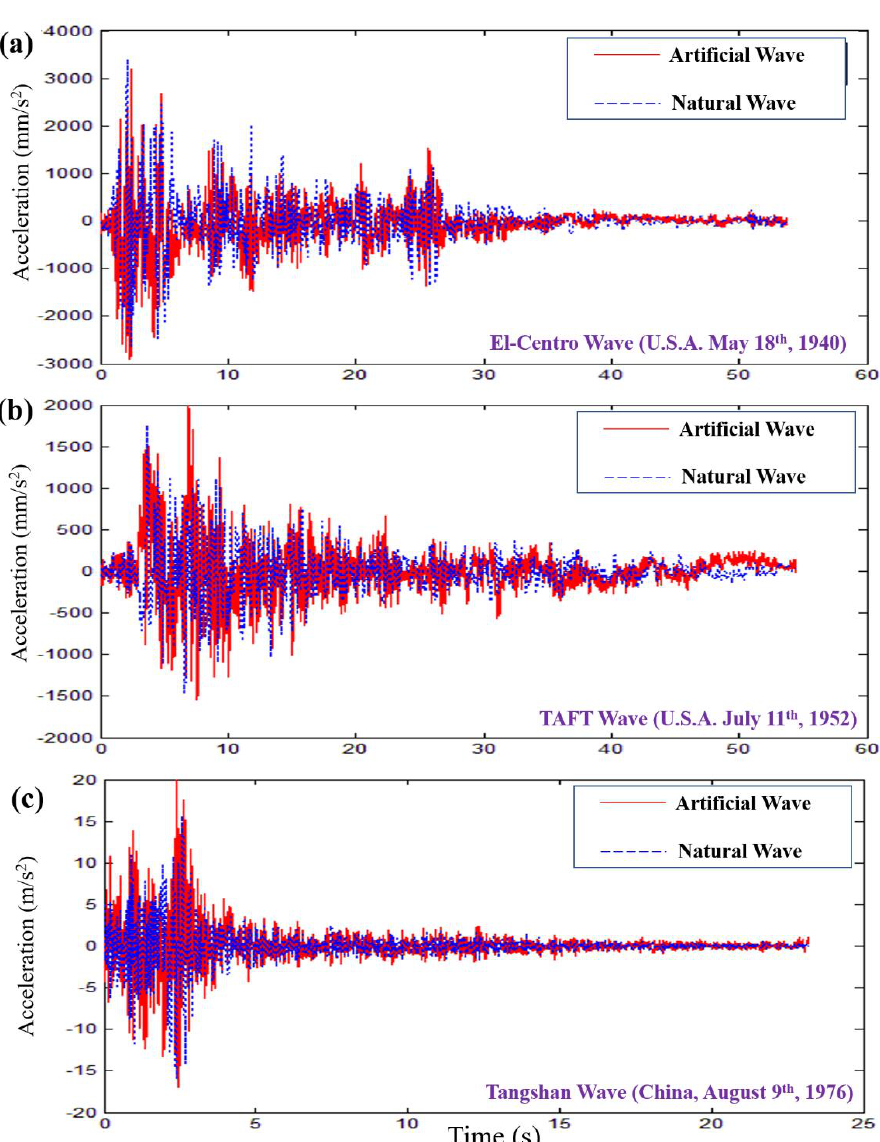
Figure 2. The comparations of the acceleration response between the artificial waves and their reference natural ones. ( a ) El Centro wave; ( b ) TAFT wave; ( c ) Tangshan Wave.